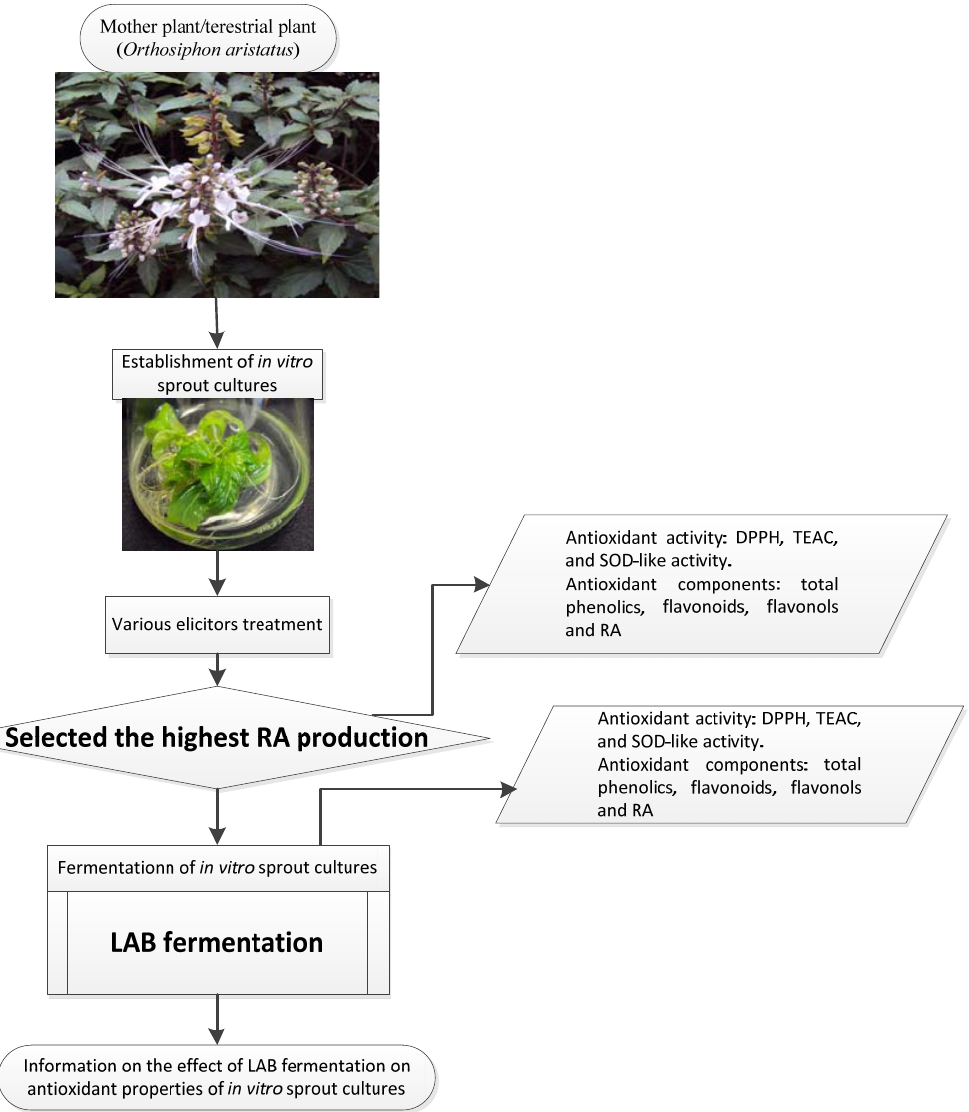
Figure 1. Flowchart of the effect of LAB fermentation on antioxidant properties of